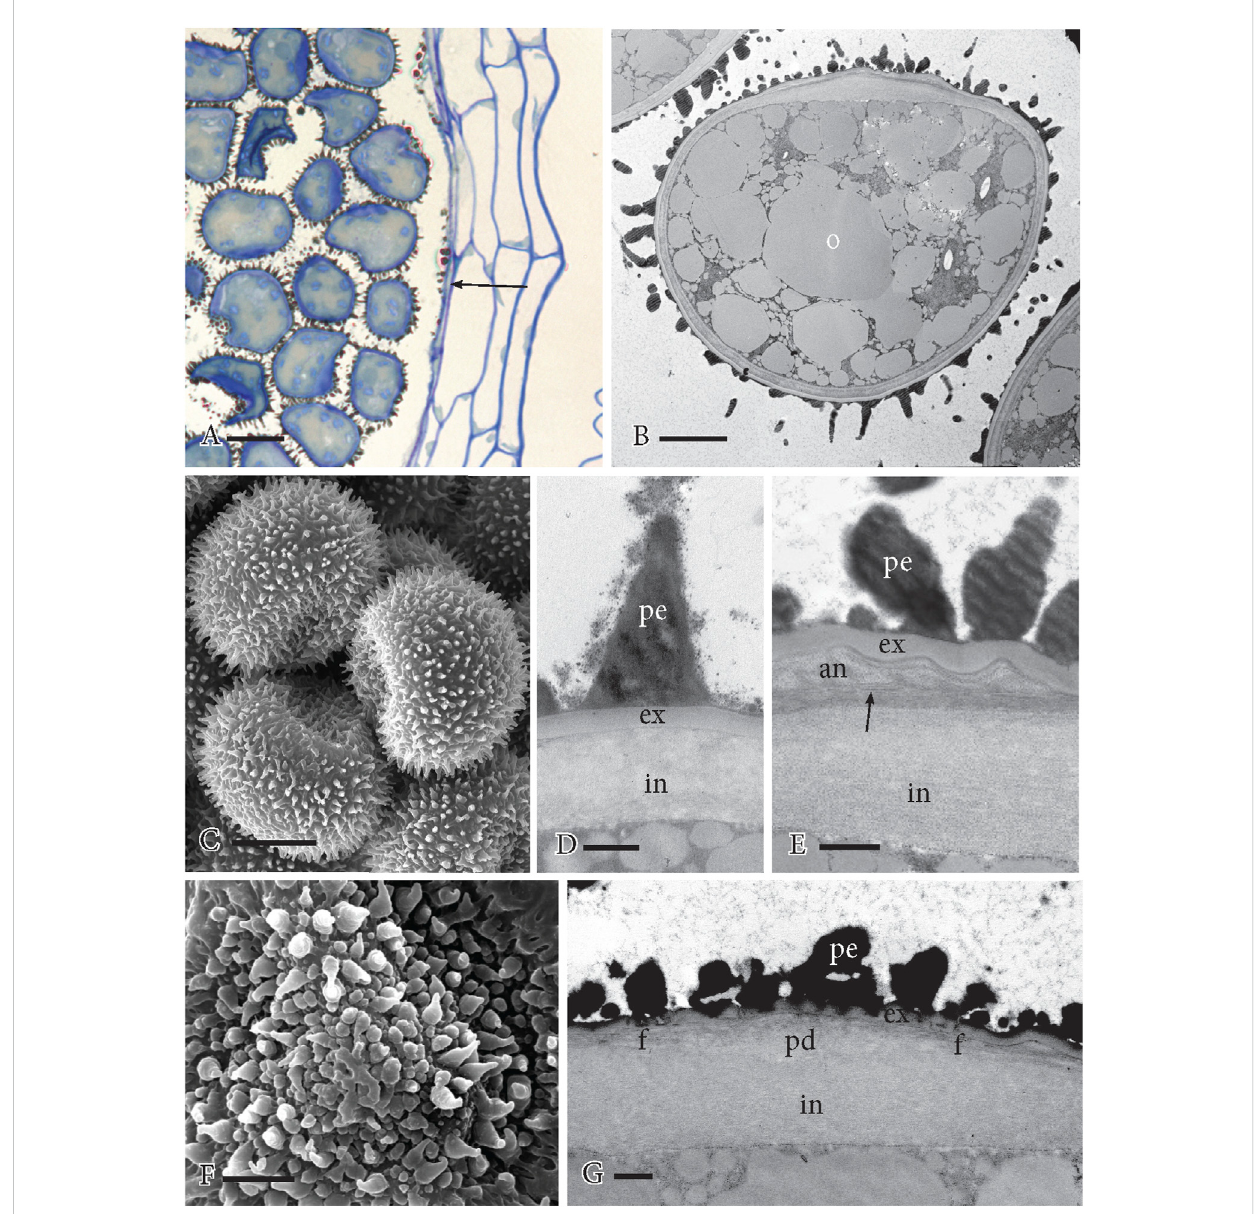
FIGURE 6 Mature spores. (A) LM section showing spiny spores fi lling the capsule locule and the 4 – 5-layered capsule wall. The inner capsule wall (arrow) is shrunken with adhering sporopollenin. (B) TEM of the mature spore engorged with oil (o) with organelles between. The proximal aperture faces up, and the distal spore is covered in perine spines. (C) SEM of three spores of a tetrad. The proximal side is concave, and the distal side is covered in spines. (D) TEM of the distal spore wall showing perine spine (pe), evenly thickened exine (ex), and thick inner intine (in). (E) TEM of the aperture region at the annulus. Wall layering from outside to insideis perine (pe), wavy exine (ex),annulus (an), TPL (arrow) and subtending fi bers, and thick intine (in). (F) SEM of the aperture on the proximal side of the spore with irregular perine ornamentation. The central pad subtends the projecting mid-region of the aperture. (G) TEM of the central pad region of the aperture. The perine (pe) and exine (ex) are irregular and thin, fi bers (f) radiate on all sides from the pad (pd), and the intine (in) is thickened. Scale bars: (A) = 20 μ m; (B) = 5.0 μ m; (C) = 10 μ m; (F) = 2.5 μ m; and (D, E, G) = 0.5 μ